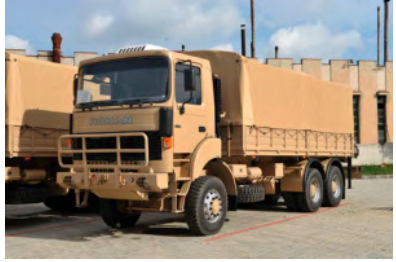
Figure 4. Tractor Truck 18.5 tons.